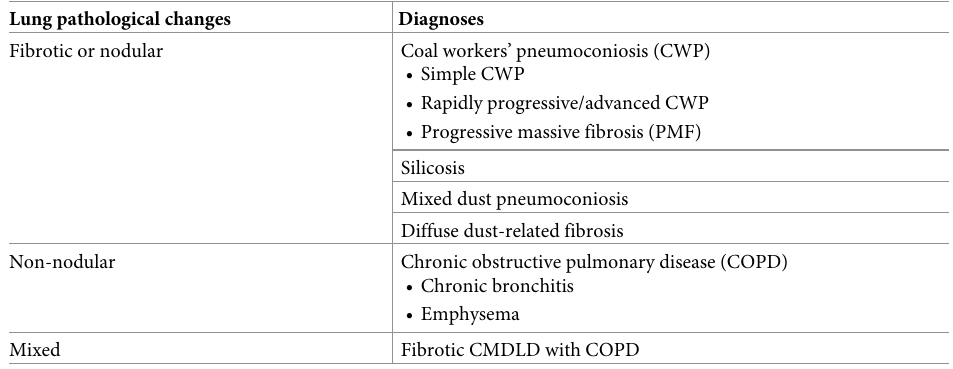
Table 1. The spectrum of coal mine dust lung disease